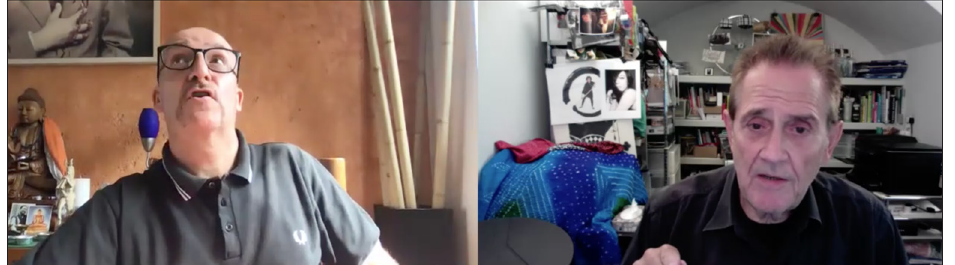
Figure 6: Earthquake via Zoom. (10:34 am CST June 23. Temblor was